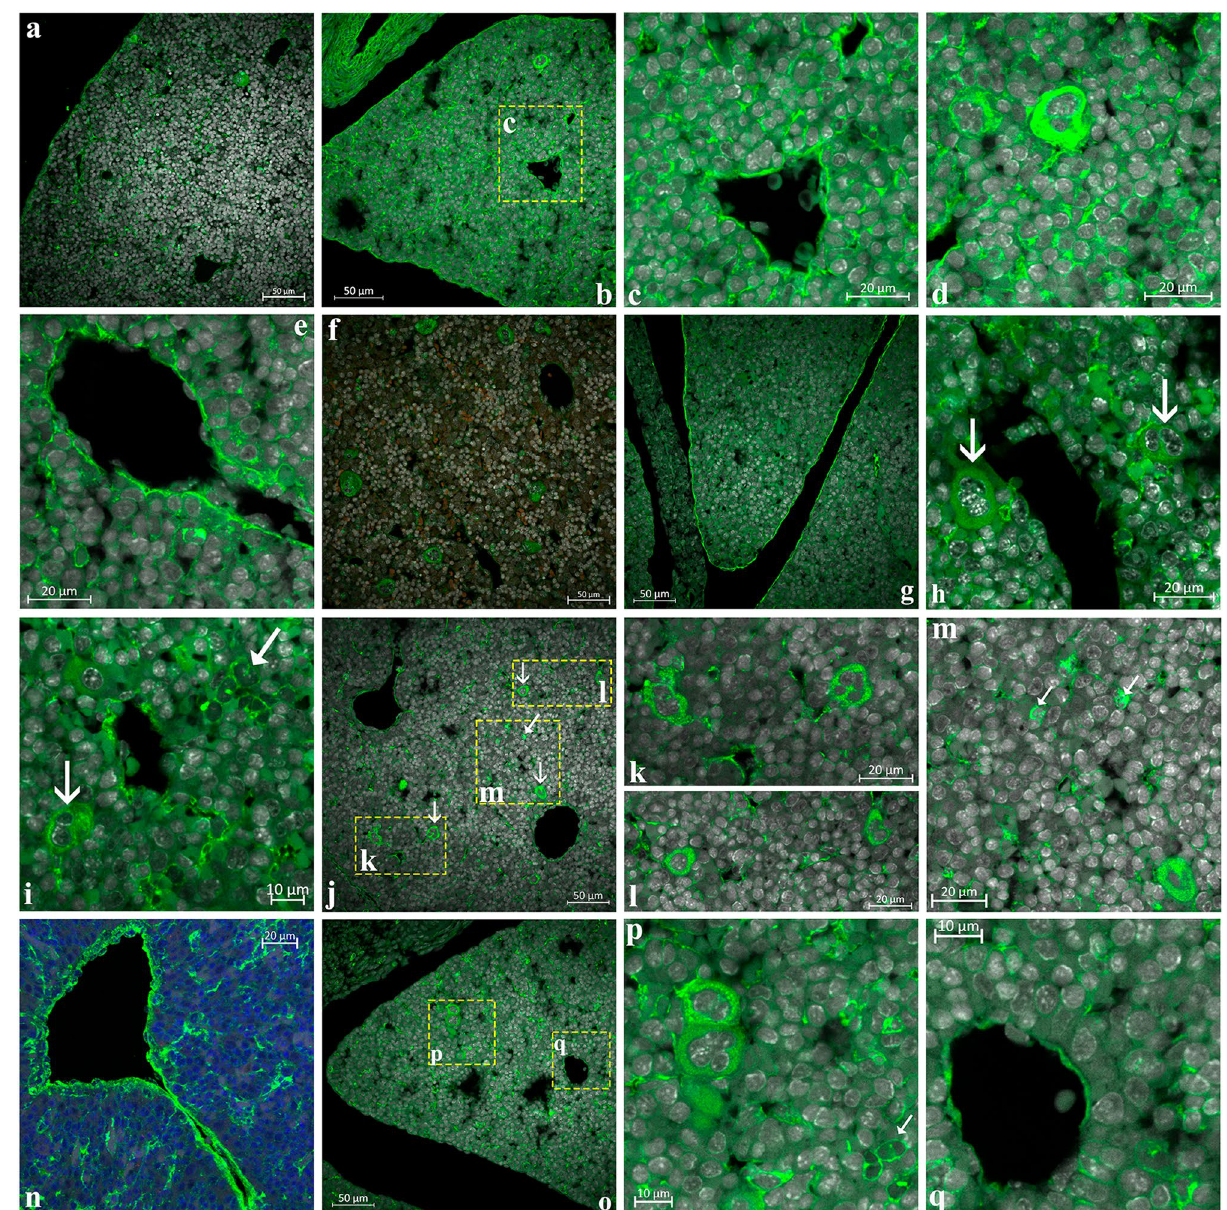
Figure 2. Galactose expression revealed by APL ( a ), Jacalin (AIL) ( b–e ), ECL ( f ), RCA ( g–i ), and complex galactose residues by PHA-E ( j–n ) and PHA-L lectins ( o–q ). An average of five fetal livers per slide from E15.5 ( f,n ) and E16.5 ( a–e,g–m,o–q ) were analyzed in two independent experiments and representative images are shown. Vessels and megakaryocytes (arrow) strongly marked by different galactose residues. Smaller cells of horseshoe shaped nucleus that resembles neutrophils, band stage (triangle point arrow) at ( i,j,m,p ). Green— AlexaFluor 488; white or blue